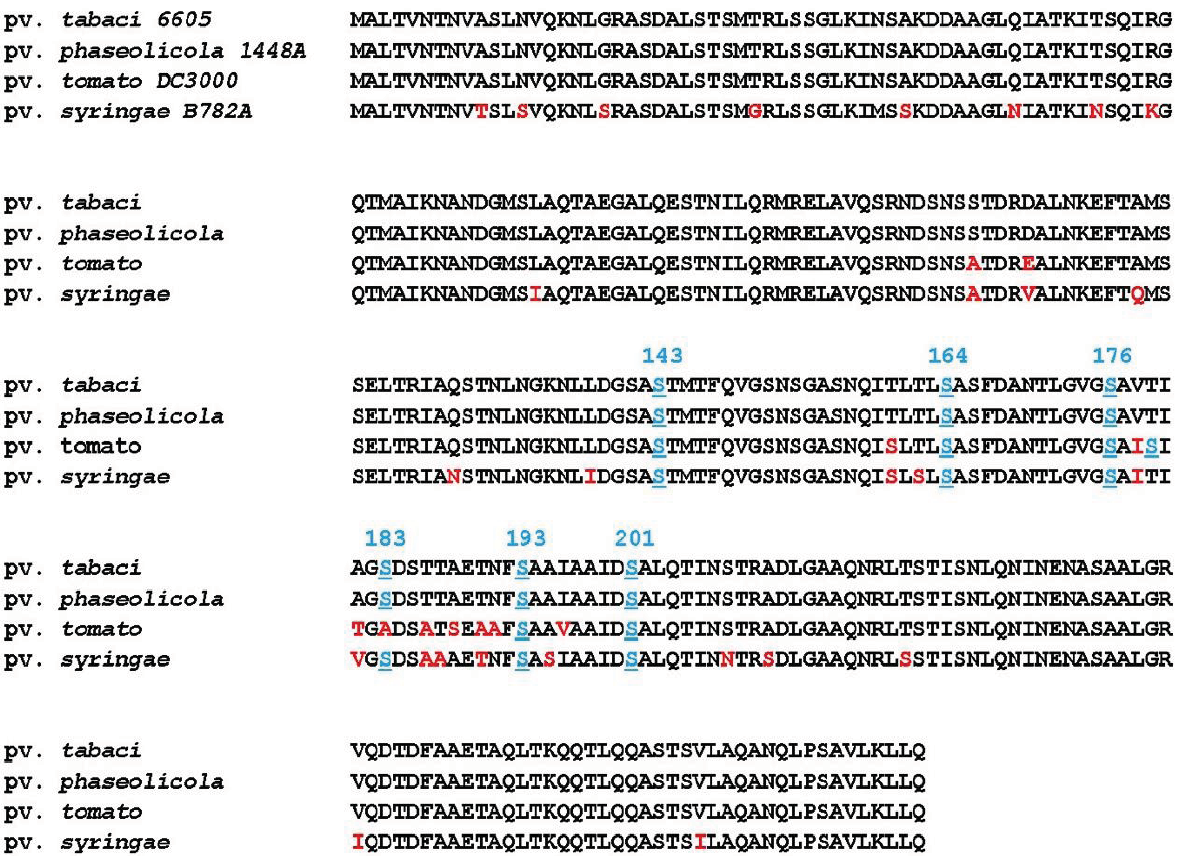
Figure 5. Comparison of amino acid sequences of flagellins among pathovars in P. syringae . Underlined light blue serine residues are glycosylated. Red letters in the sequences of pvs. tomato DC3000 and syringae B728A show different amino acids from that of pv. tabaci